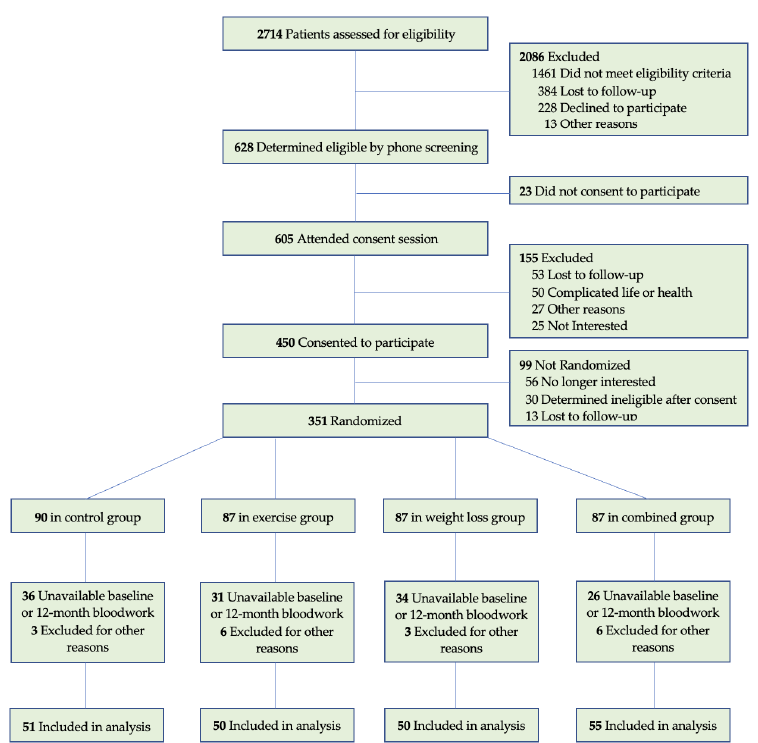
Figure 1. Two hundred and six of the 351 women who participated in the WISER Survivor trial were included in this analysis. Participants were excluded if baseline or follow-up biomarker data was not available ( n = 127) (due to inadequate sample availability to assay, loss to follow up, or not meeting quality control), or self-reported as non-fasting prior to blood draw ( n = 10), or if insulin, C-peptide or glucose fell outside of the usable range for the homeostatic model assessment 2 (HOMA2) formulas (indicating a non-fasting blood draw, n = 8).